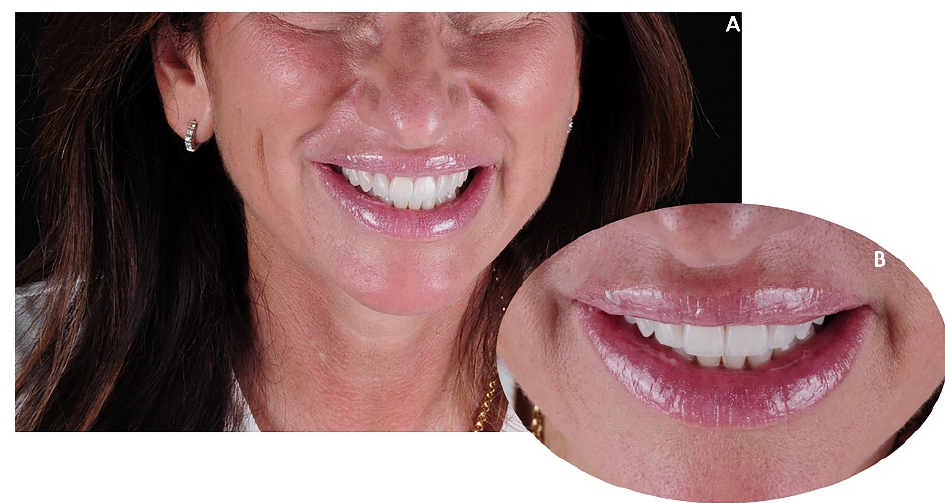
Figure 6. Case 1. ( A ) The mock-up served as reference guide to define the thicknesses of the prosthetic preparation; ( B ) teeth preparation; ( C ) final ceramic veneers and aesthetic rehabilitation.